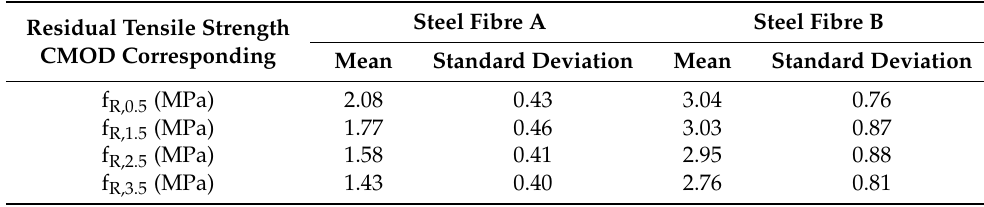
Table 5. Results of the residual tensile strength in